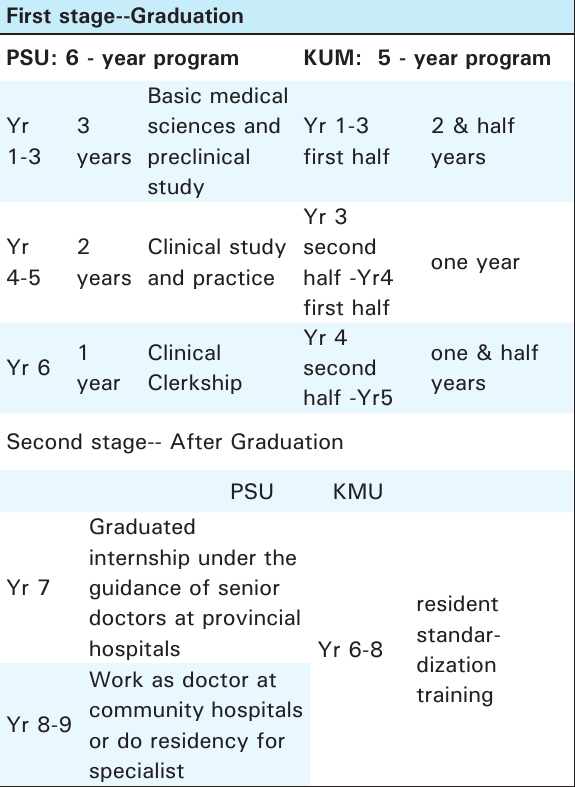
Table 1. Comparison of Medical Education